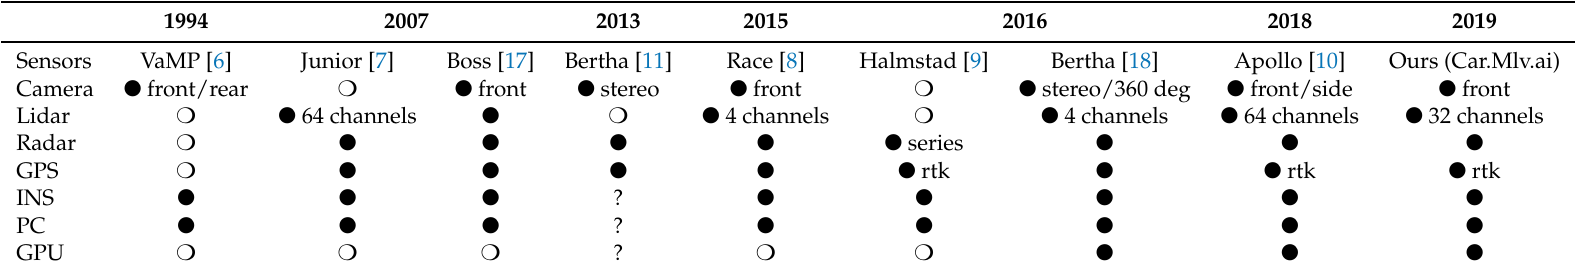
Table 8. Hardware comparison of the relevant research-based autonomous vehicle is shown. (cid:108) indicates an existing component, (cid:109) shows the nonexistence of specific component and ? explains that the required information is not public. For reference, DARPA challenges and Apollo are considered for comparison.